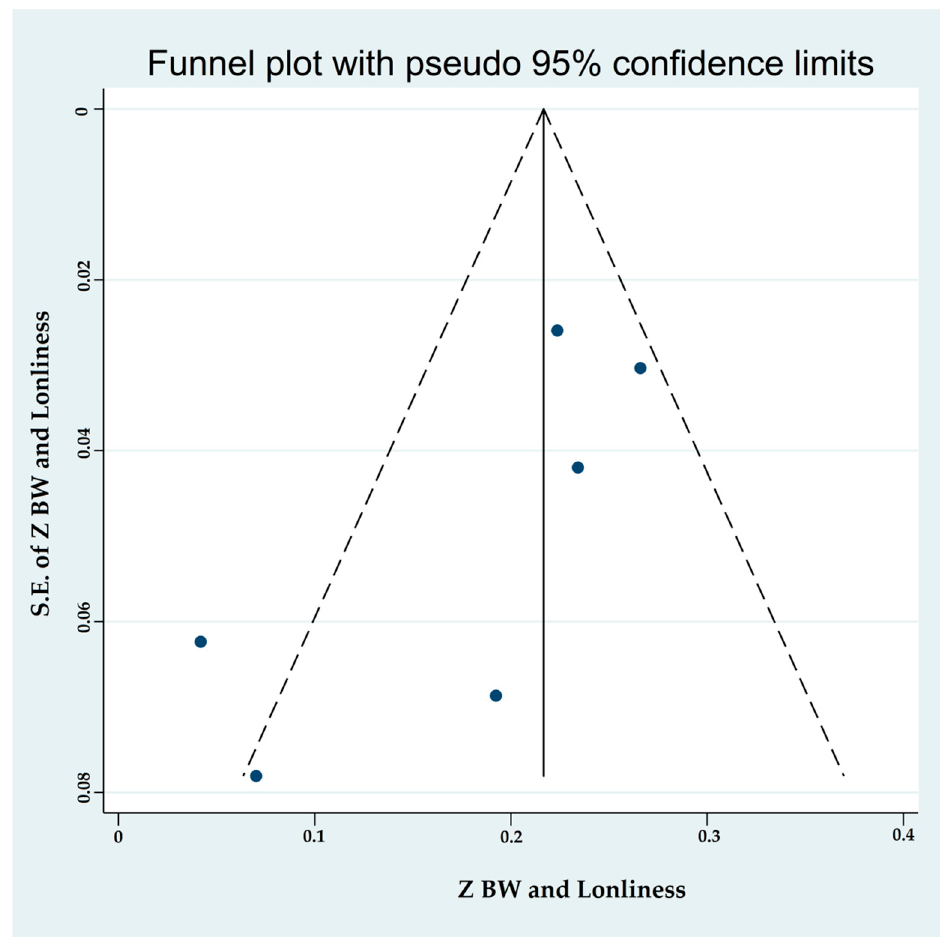
Figure 12. The forest plot displaying the estimated pooled Fisher’s z-score in the association between binge-watching and loneliness.